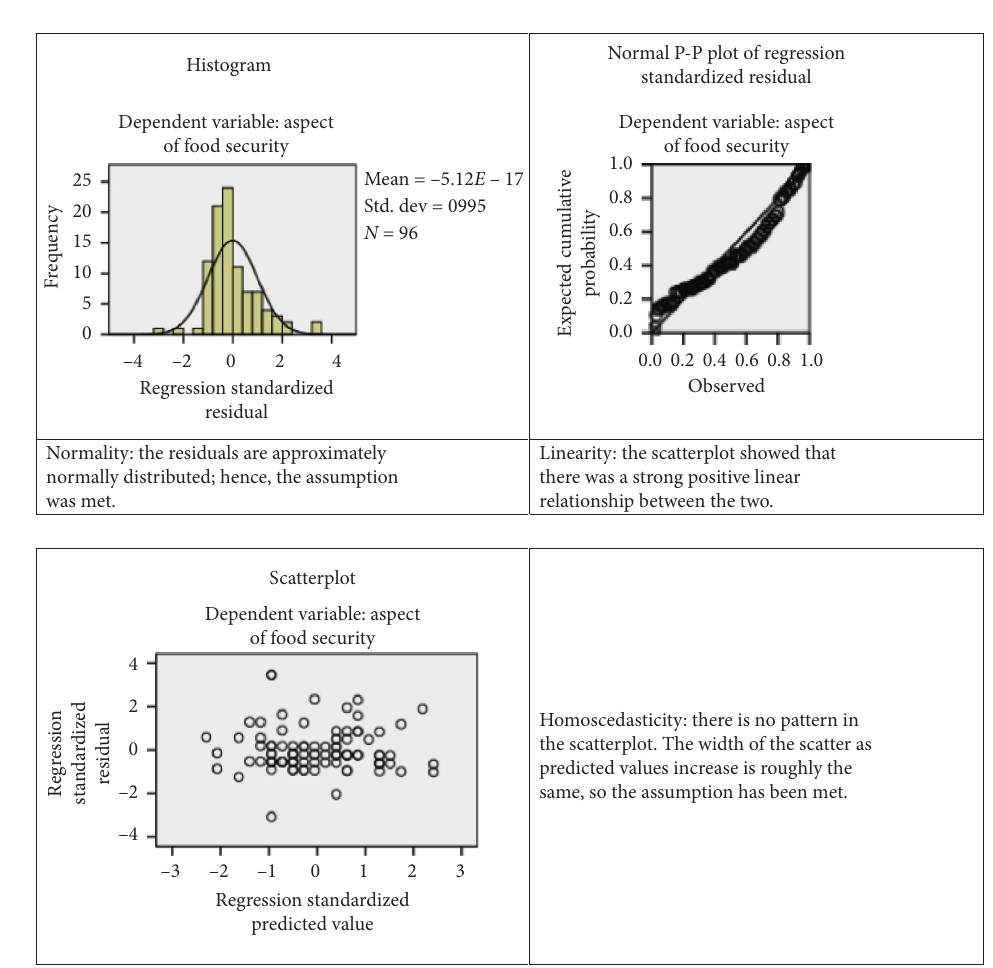
Figure 2: Test for normality, linearity, and homoscedasticity. Table 2: Rate at which each teaching approach develops skills for food security. Most important Important Least